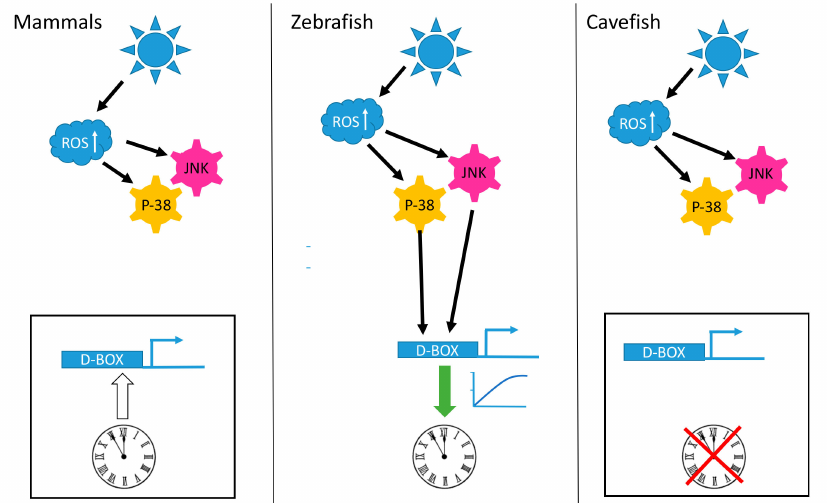
Figure 1. Light, reactive oxygen species (ROS) and the D-box enhancer. Schematic representation of how D-box enhancer-driven gene expression is di ff erentially influenced by blue light exposure in mammalian, zebrafish and cavefish cells. In all three cell types light triggers an increase in intracellular ROS levels that in turn activates the p-38 mitogen-activated protein kinase (MAPK) and c-Jun NH 2 terminal kinase (JNK) stress pathways. In zebrafish cells (central panel), this signaling results in the activation of D-box-driven gene expression, ultimately leading to circadian clock entrainment (indicated by the green arrow). In mammalian cells (left panel) and in cavefish cells (right panel) this signaling fails to activate gene expression via the D-box enhancer element and does not entrain the circadian clock. The white arrow starting from the clock and pointing on the D-box element indicates the circadian clock regulation of this enhancer in mammals [132]. The red cross over the clock in the cavefish cells indicates the blind circadian clock observed in these cells